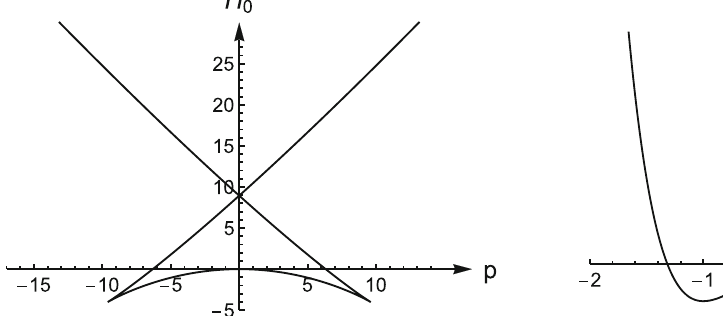
shapes like a two-dimensional Mexican hat. In both plots we set λ = 1 and a = 1. For general quantities, the true vacua are at ˙ a = ± λ 1 / 4 a , √ = − 4 a 3 / corresponding to H min 0